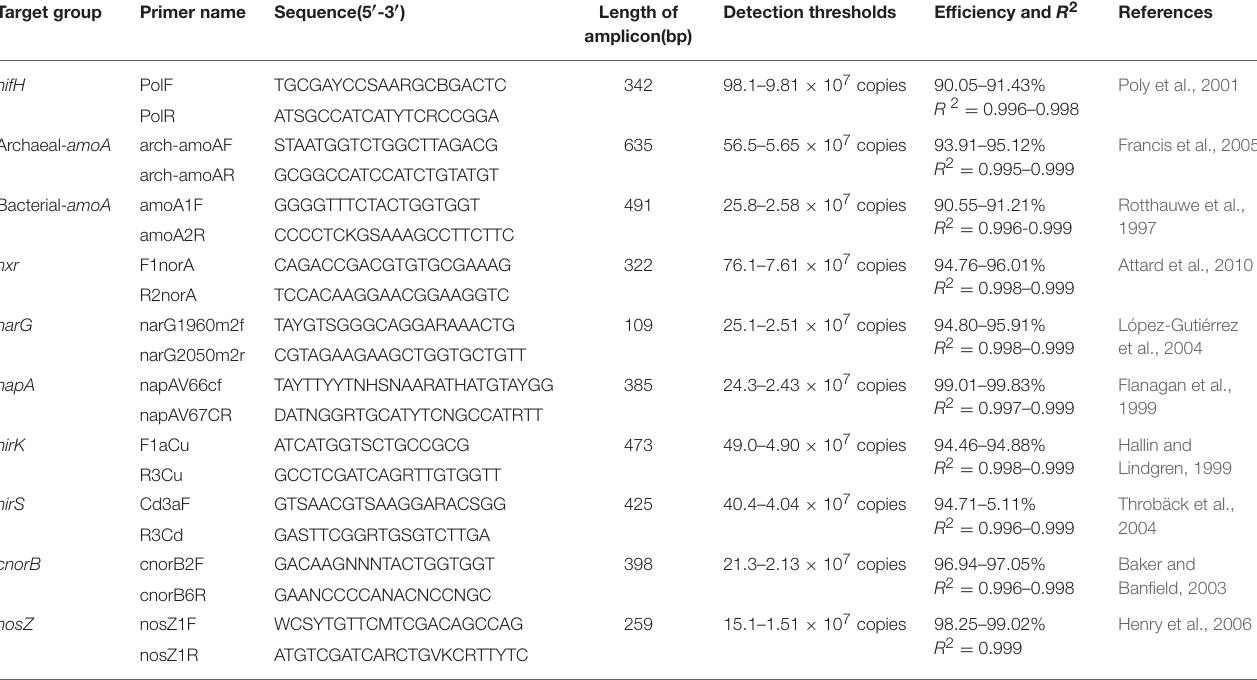
TABLE 1 | Primer pairs used in real-time qPCR analysis for amplification of nitrogenase ( nifH ), bacterial and archaeal ammonia monooxygenase ( amoA ), nitrite oxidoreductase ( nxr ), nitrate reductase ( narG and napA ), nitrite reductase ( nirK and nirS ), nitric oxide reductase ( cnorB ), and nitrous oxide reductase ( nosZ ) genes. Target group